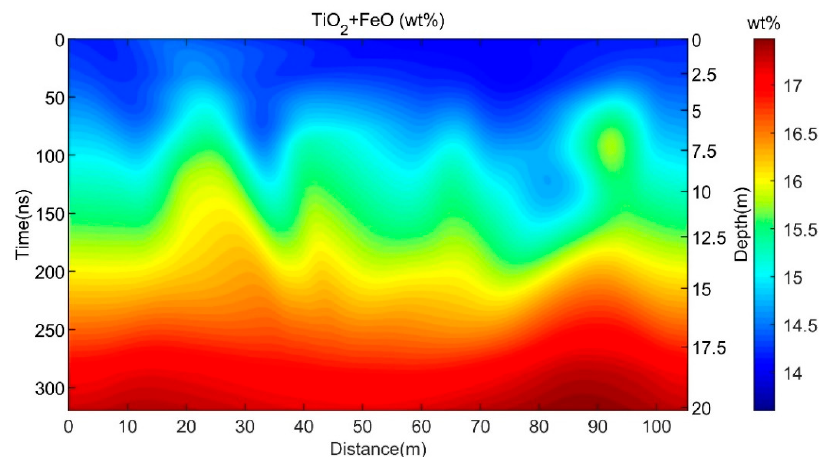
Figure 13. The density structure of lunar regolith.